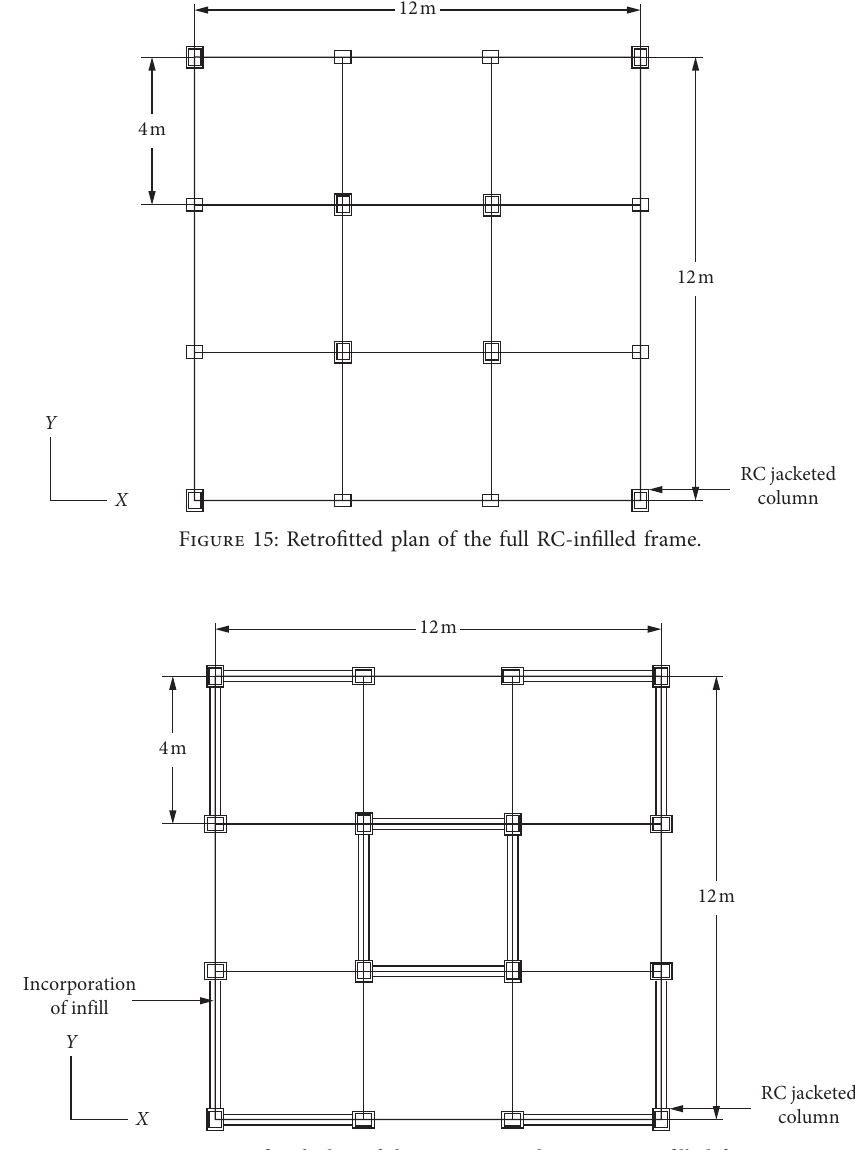
Figure 16: Retrofitted plan of the open ground storey RC-infilled